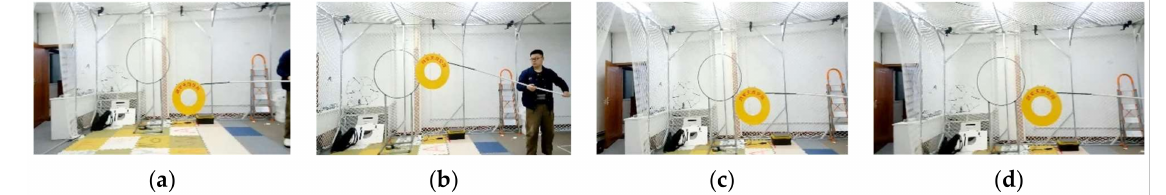
Figure 19. Indoor moving target tracking scene: ( a – d ) is a schematic diagram of the scene of a moving platform tracking a circular target.